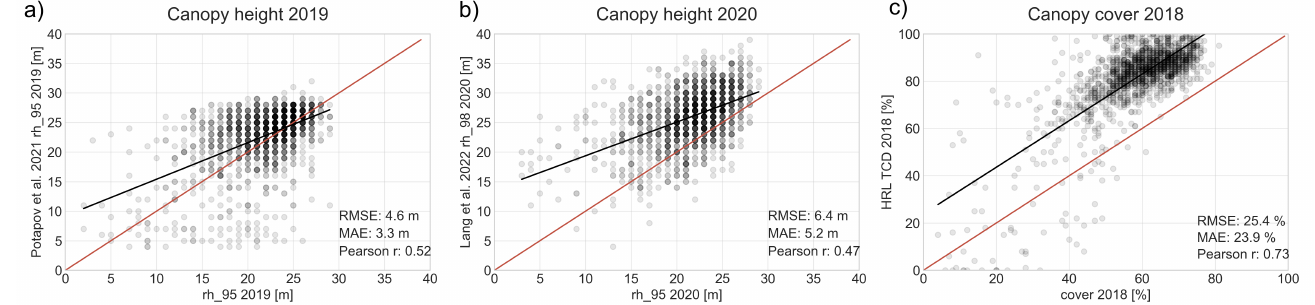
Figure 5. Comparison of modeling products from the present study (x-axes) with canopy height models from Potapov et al., 2021 ( a ) [36] and Lang et al., 2022 ( b ) [37]. Potapov et al., 2021 modeled canopy height as the 95th percentile from GEDI L2A 2019 data, whereas Lang et al., 2022 generated a canopy height model for 2020 based on the 98th percentile. The total canopy cover product was compared to the Copernicus HRL tree cover density (TCD) layer [28] ( c ). Model validation is based on 1500 samples that were randomly generated in forested areas lower than 52°N (northern latitudinal limit of Potapov et al., 2021 product